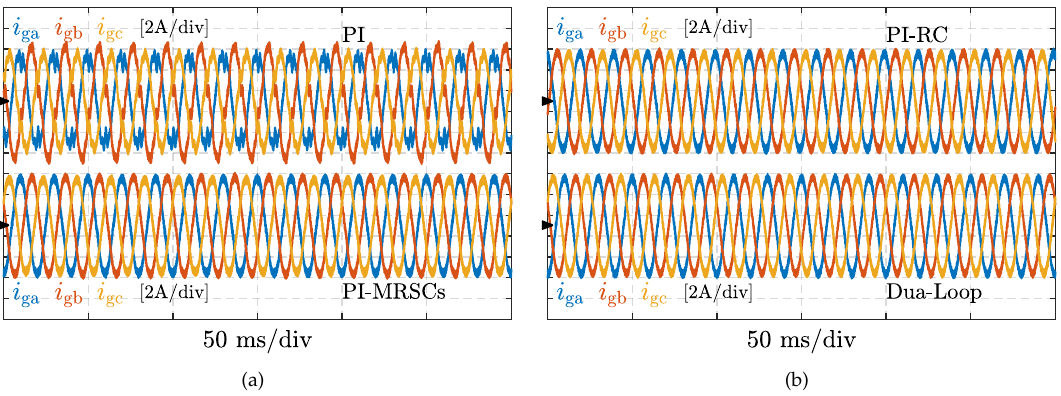
Figure 14. Grid currents under distorted voltages and voltage measurement errors: ( a ) Traditional controllers without additional compensation schemes ( above ) and the conventional compensation scheme based on MRSCs ( bottom ); ( b ) The conventional compensation scheme based on the plug-in RC ( above ) and the proposed dual-loop controller( bottom